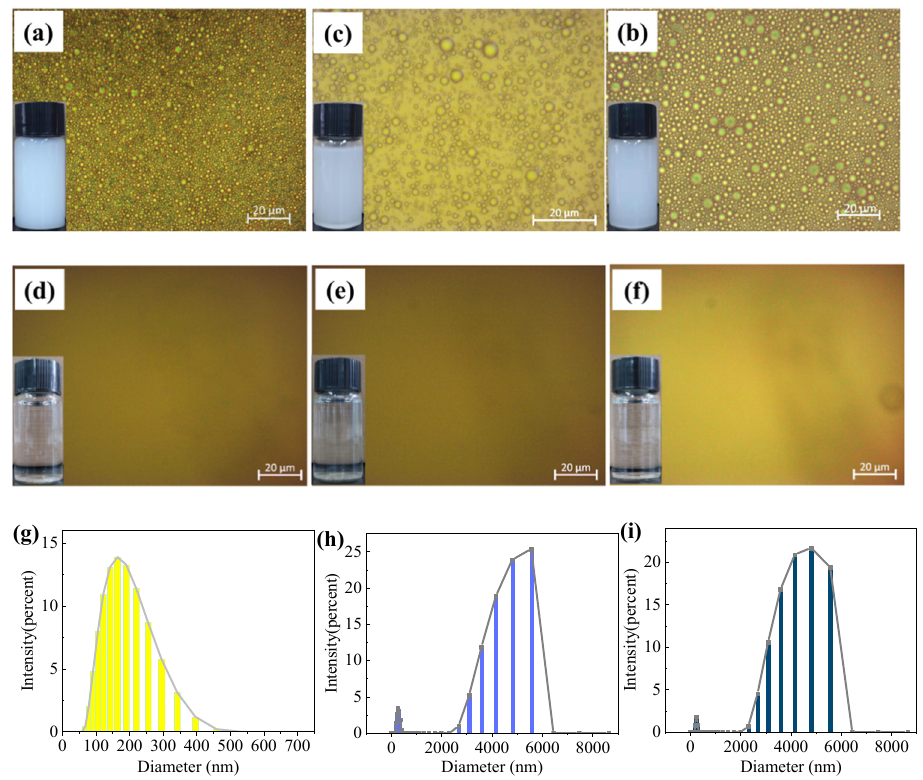
Figure 5. Optical microscope and droplet size distribution images of SDS-stabilized oil-in-water emulsions: ( a , d , g ) soya-bean oil, ( b , e , h ) mineral oil and ( c , f , i ) pump oil.